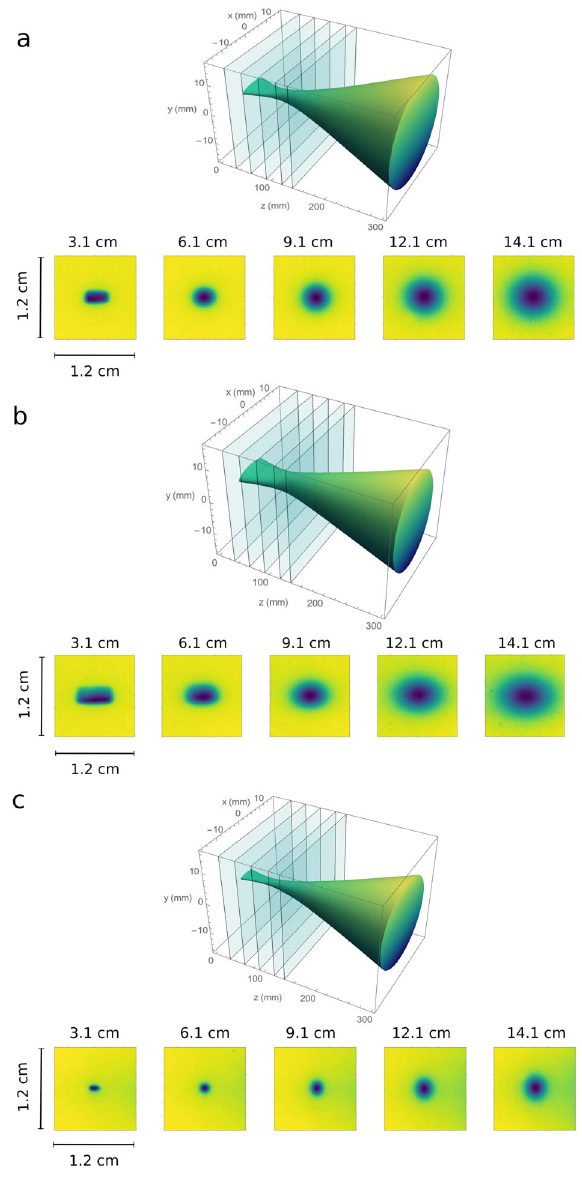
Fig. 3 3D reconstruction of the dose pro fi les based on measured radiation beam pro fi les using EBT3 fi lms. a 158 MeV with f/ 11.2, b 158 MeV with f/ 12.3 and c 201 MeV with f/ 18.2 focused beams with selected EBT3 fi lm samples placed at depths of 3.1, 6.1, 9.1, 12.1, 14.1 cm in